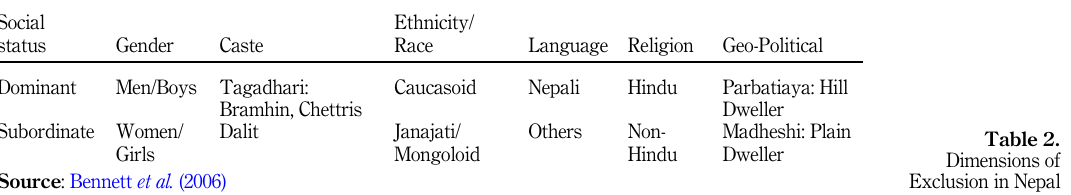
Table 2. Dimensions of